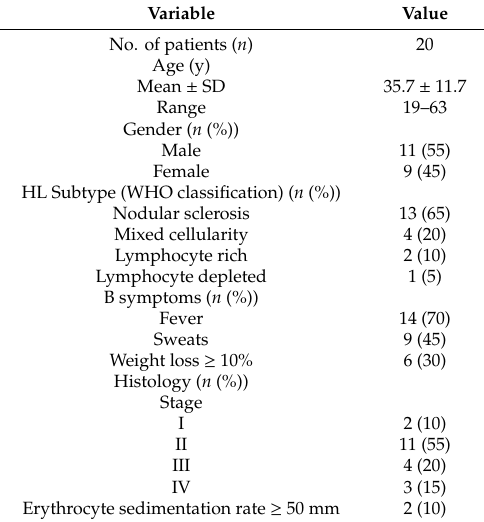
Table 1. Characteristics of study population.